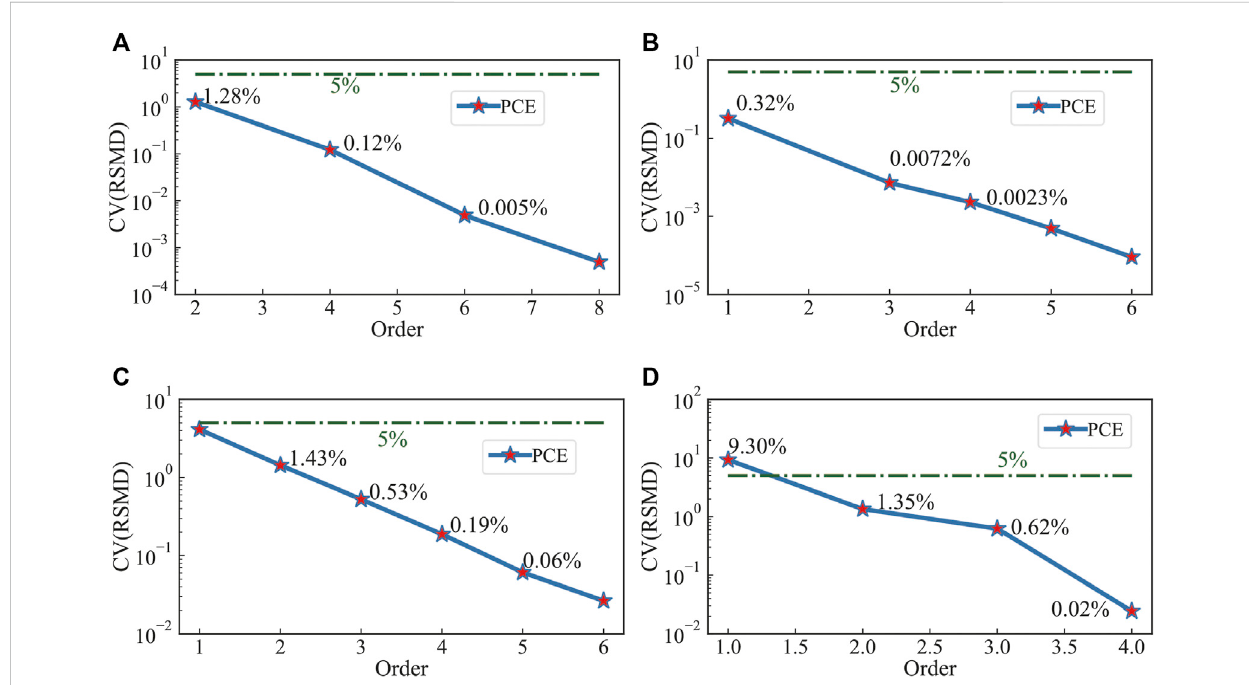
FIGURE 7 CV (RSMD) with respect to different variables. (A) PEC model, θ sca ∈ [0,2 π ], f =10MHz; (B) DIE model, ε 1 ∈ [30,50], f =10MHz, θ sca =0; (C) PEC model, f ∈ [1,1000] MHz, θ sca = π ; (D) DIE model, f ∈ [130,150]MHz, ε 1 =2.56, θ sca =0.